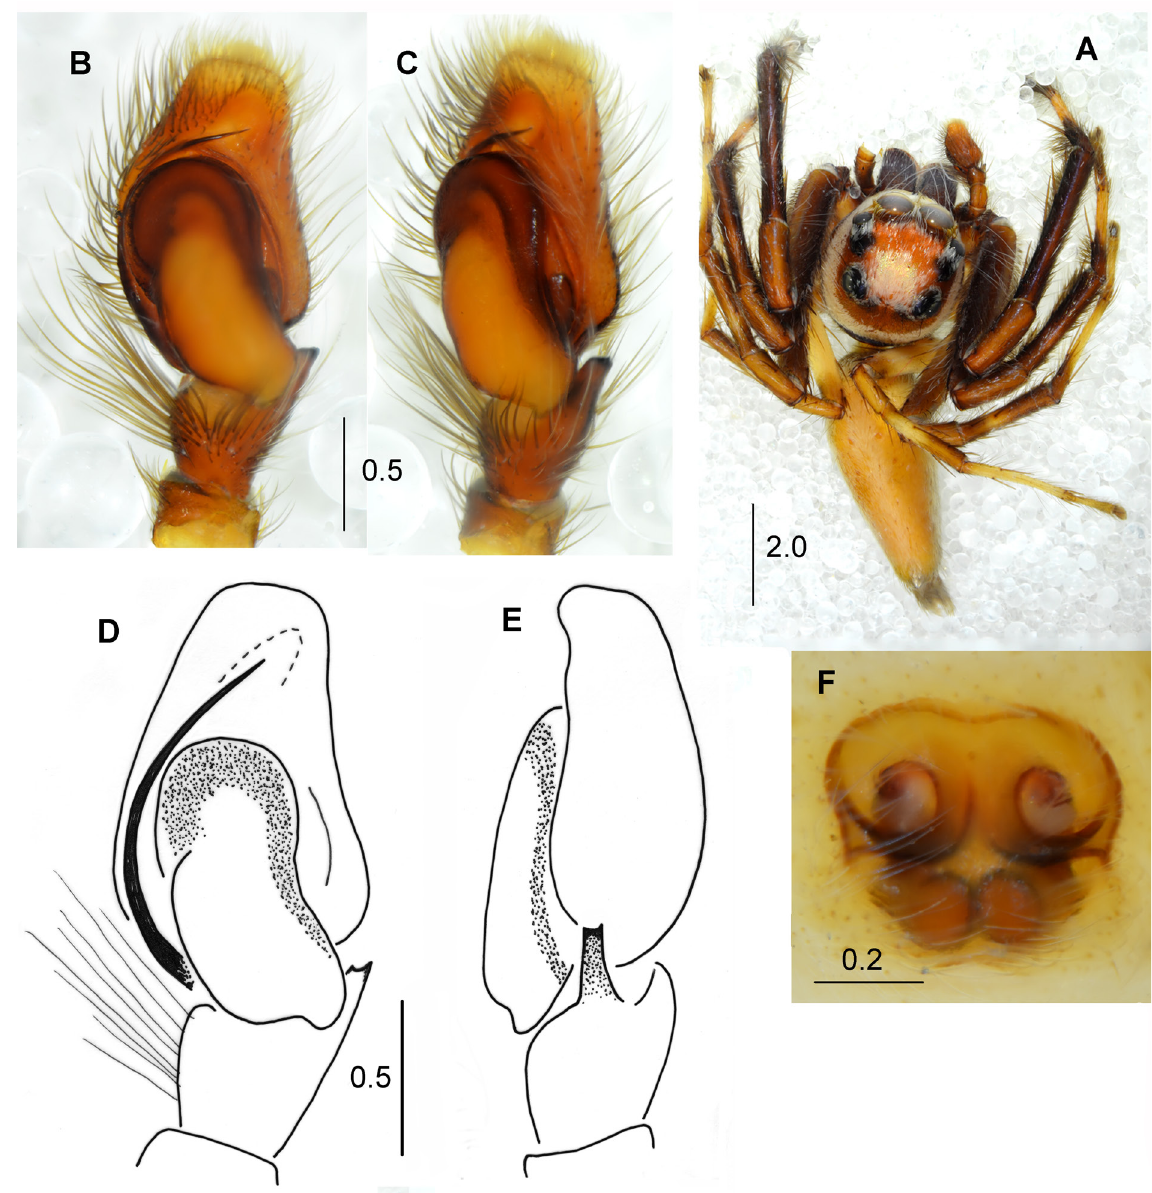
Fig. 79. Vicirionessa fuscimana (Simon, 1903) gen. et comb. nov., ♂♀ (MNHN). A . Habitus of male, dorsal view. B, D . Palpal organ, ventral view. C . Palpal organ, ventrolateral view. E . Palpal organ, lateral view. F .